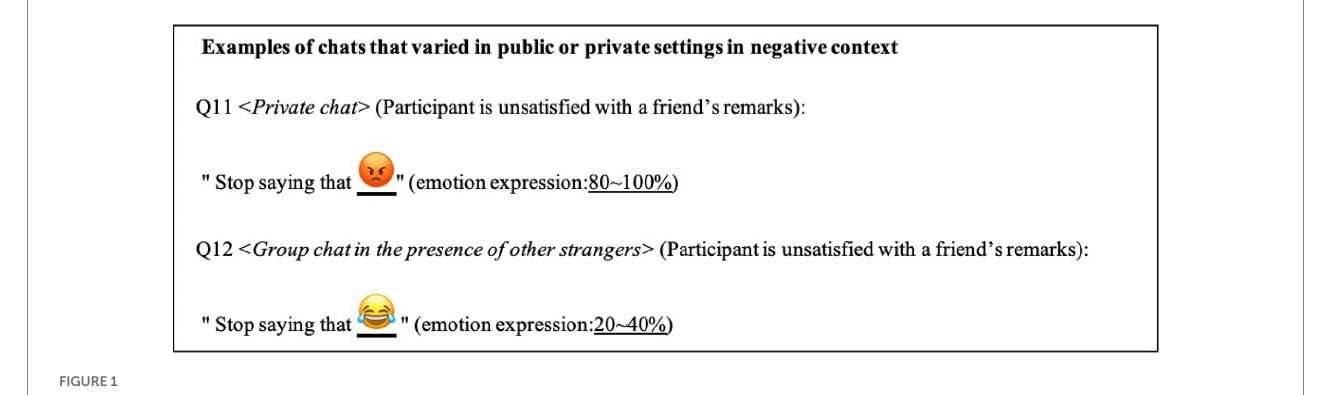
FIGURE 1 Example answers of Internet